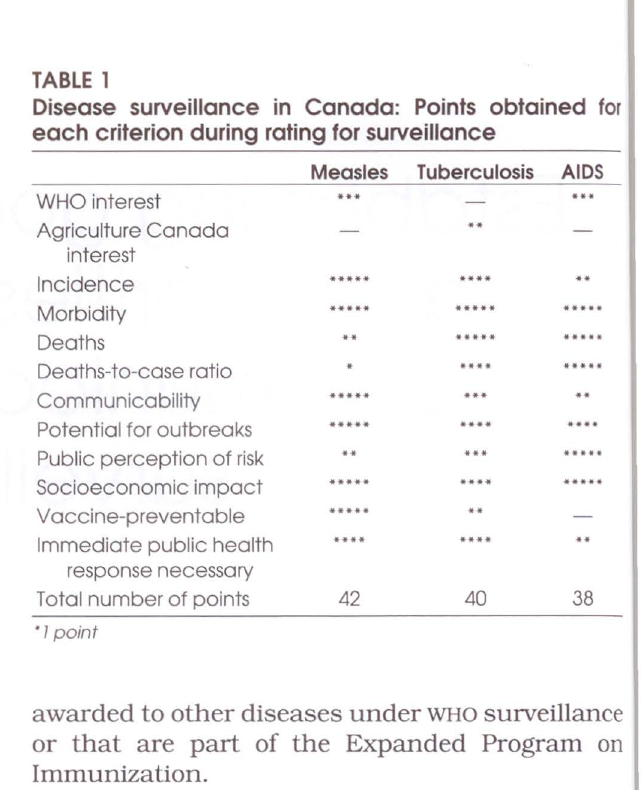
Disease surveillance in Canada: Points obtained for each criterion during rating for